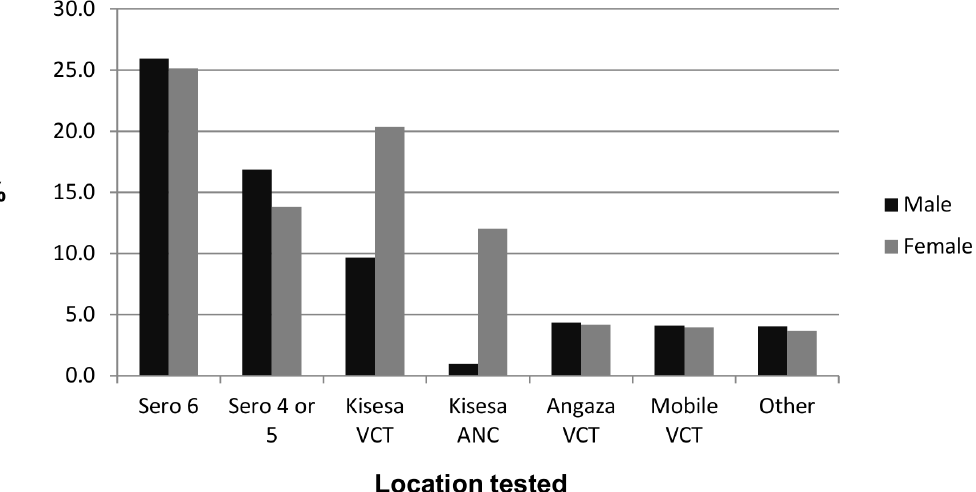
Figure 3. Among those who attended Sero 6, proportions of men (n=3,131) and women (n=4,877) using different HCT services. doi:10.1371/journal.pone.0062212.g003 PLOS ONE |